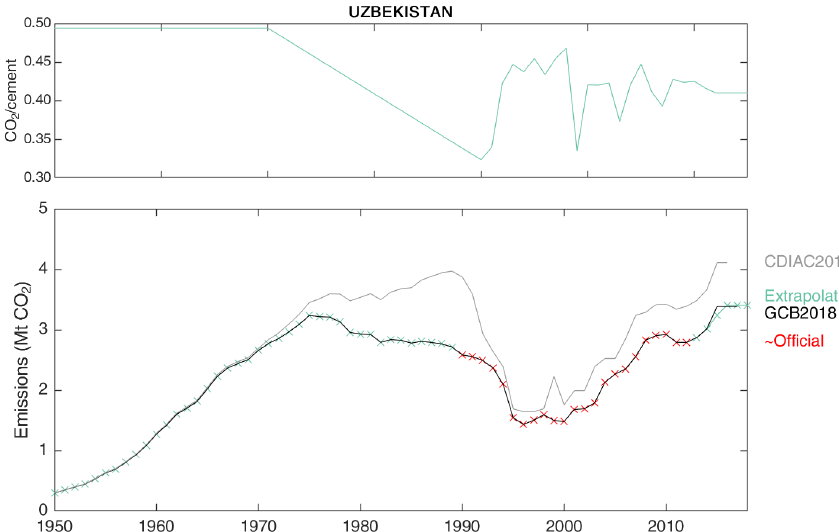
Figure C42. Revised cement emissions in Uzbekistan.